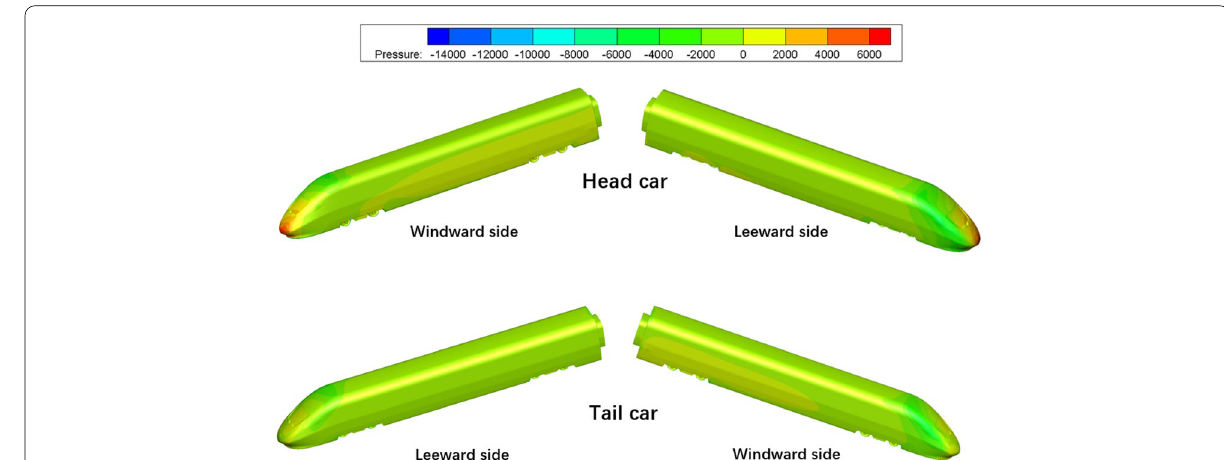
Figure 11 Pressure distribution of the head car and tail car (Pa)